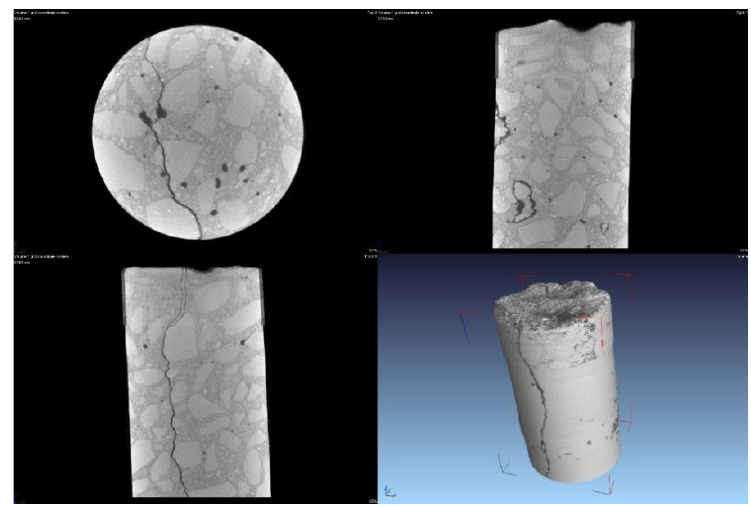
Figure 1. X-ray CT scan image .